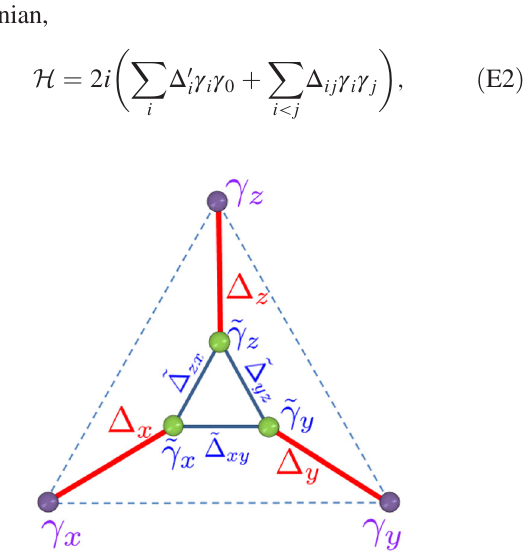
FIG. 7. Underlying substructure of the setup in Fig. 1. The central Majorana mode γ 0 emerges from the low-energy subspace of three strongly coupled Majoranas ~ γ i